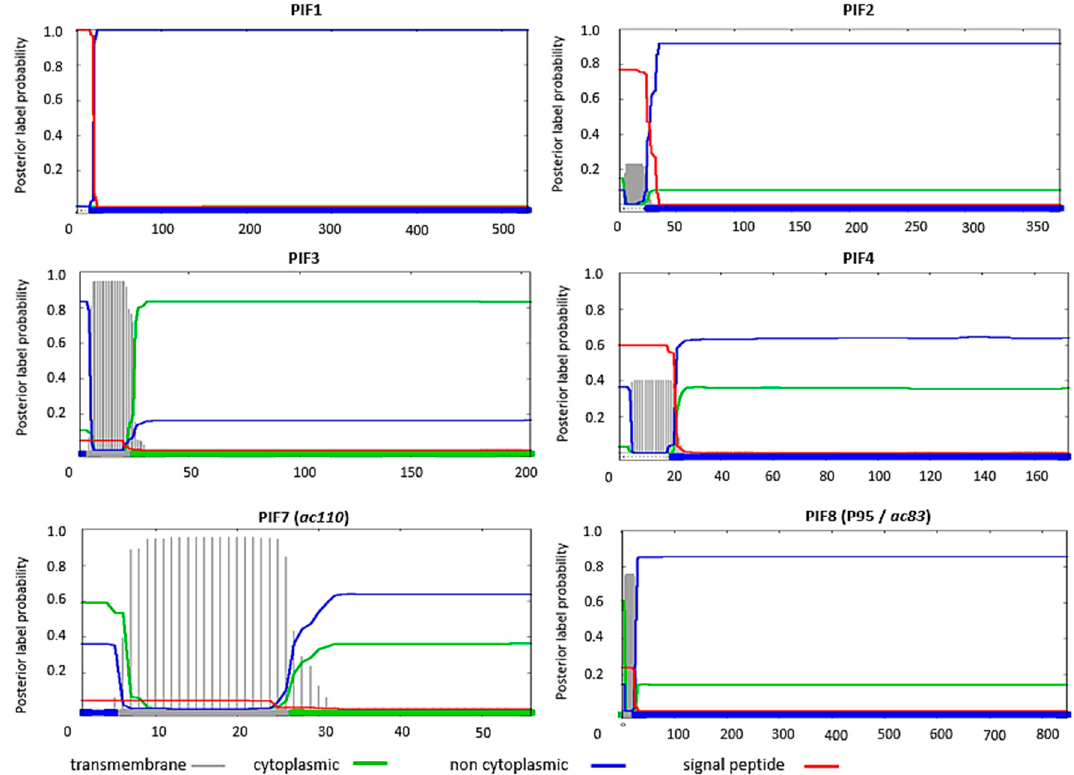
Figure 1. Prediction of the presence of transmembrane domains and signal peptides in per os infectivity factors (PIFs) and orientation of these proteins in in an infected host-cell with the Phobius algorithm [17]. On the y -axis: the probability for the presence of transmembrane domains (grey), cytoplasmic (green) or non-cytoplasmic (blue) orientation of the amino acid sequence and presence of a signal peptide (red). The final result of the prediction is summarized by the bar at the bottom with the indicated colours. The x -axis shows the number of the amino acids of that specific sequence. PIF1, PIF2, PIF3, PIF4, PIF7 ( ac110 ) and PIF8 (P95/ ac83 ) are predicted to have an N-terminal signal peptide or transmembrane domain.